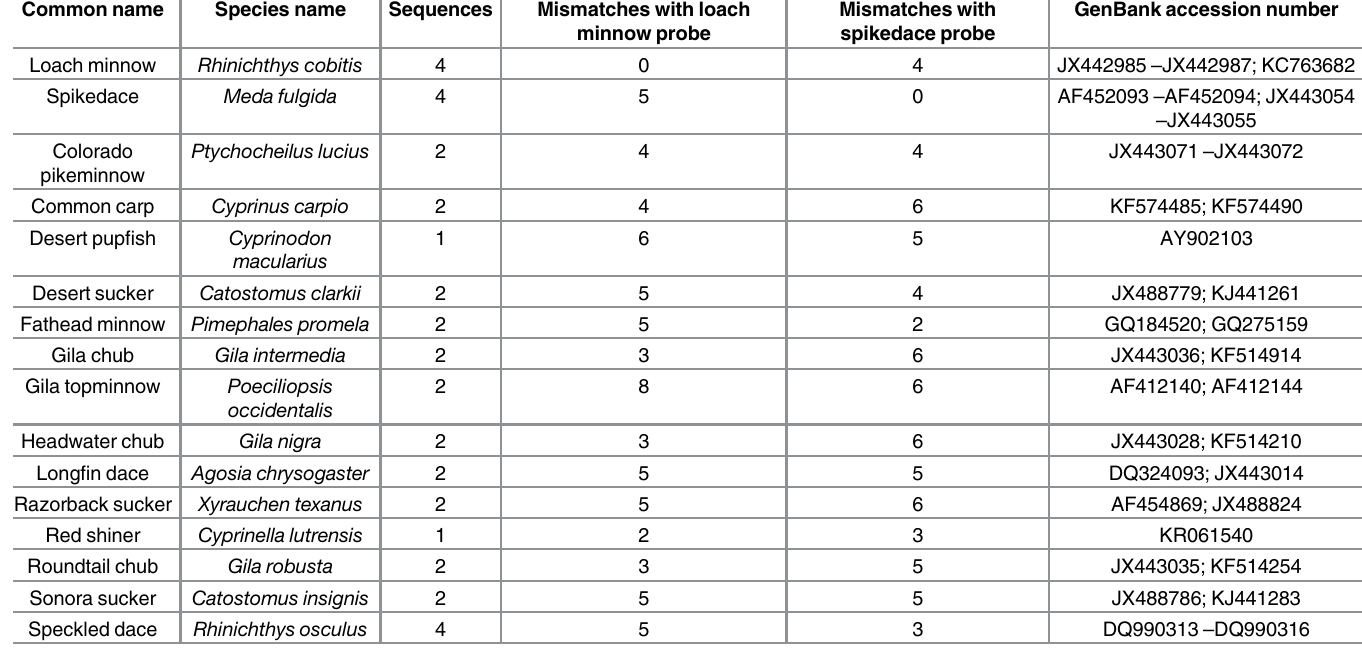
Table 1. Species, sample size, and GenBank accession number for DNA sequences used for in silico marker development.